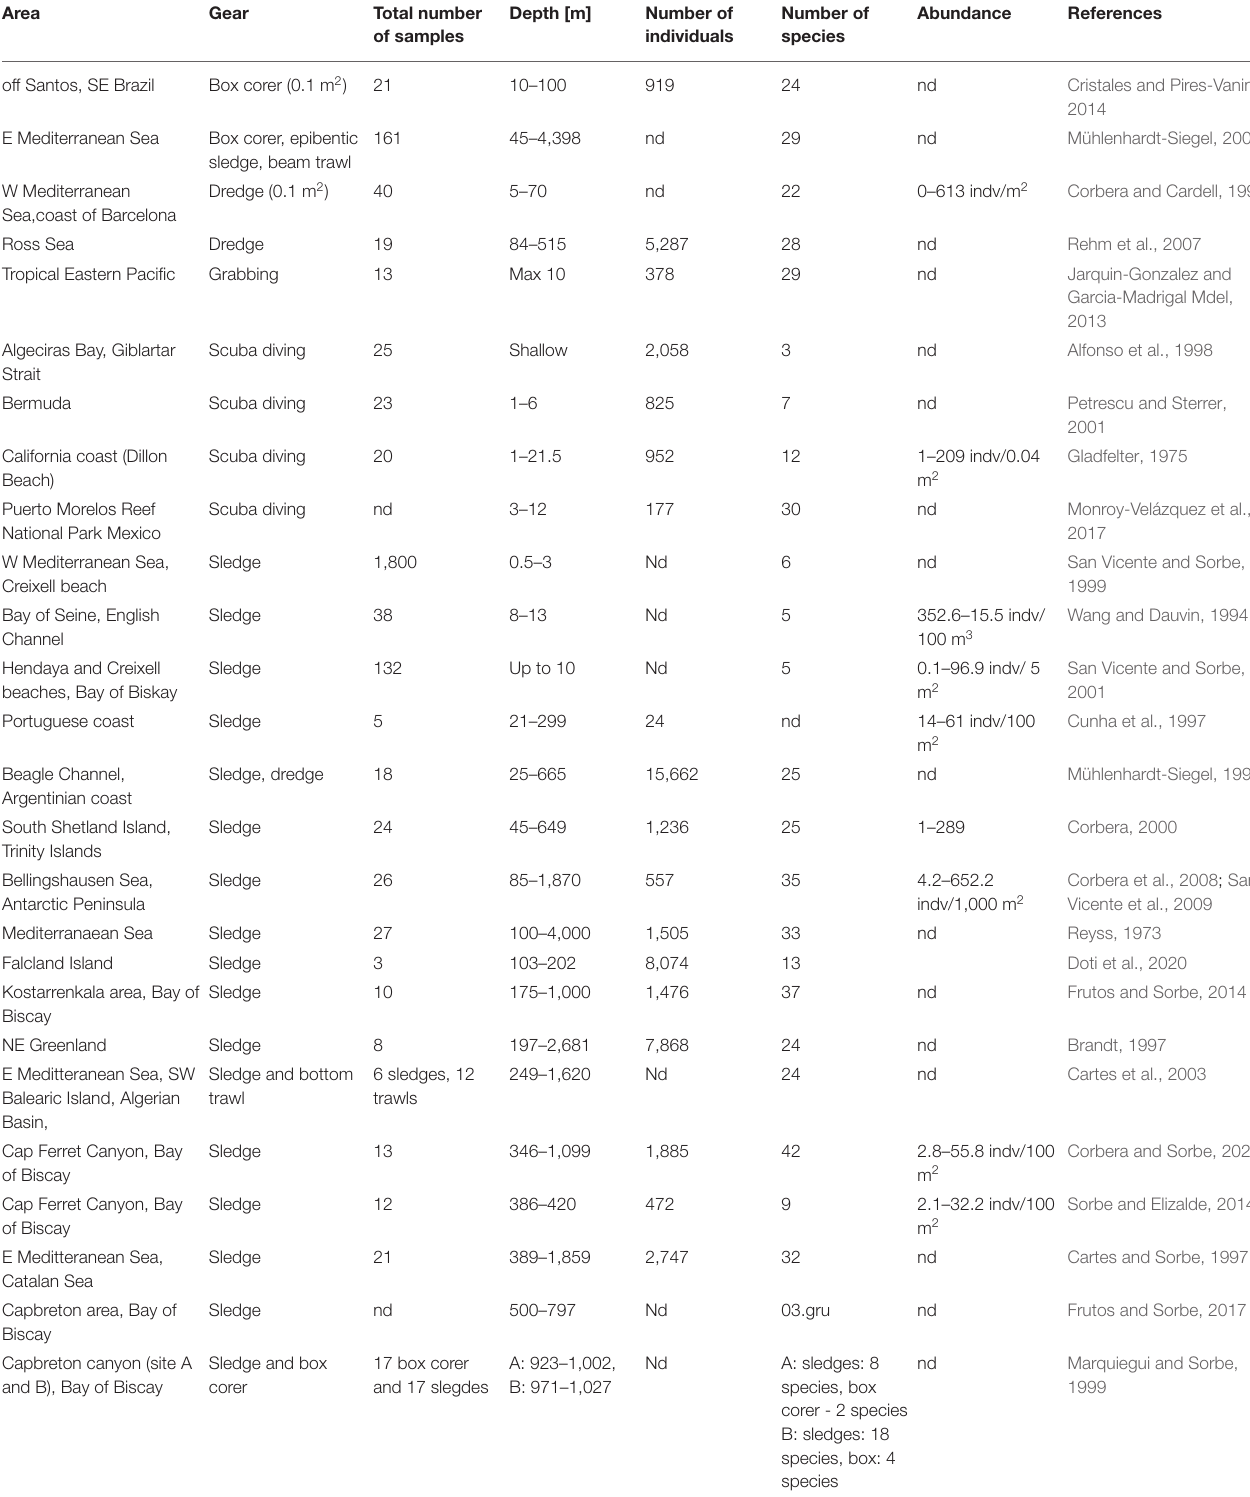
TABLE 6 | Sampling effort, species richness, and total abundance of Cumacea from various